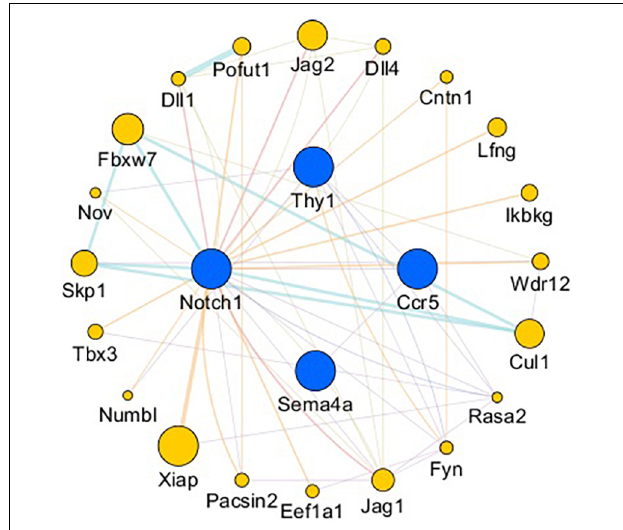
FIGURE 7 | Gene interaction network. Blue nodes: Genes related to axonogenesis, angiogenesis, and the immune response. Yellow nodes: Genes that interacted with CCR5, Thy1, Notch1, and Sema4A. The node size is based on the score. The larger the node is, the higher the score will be.